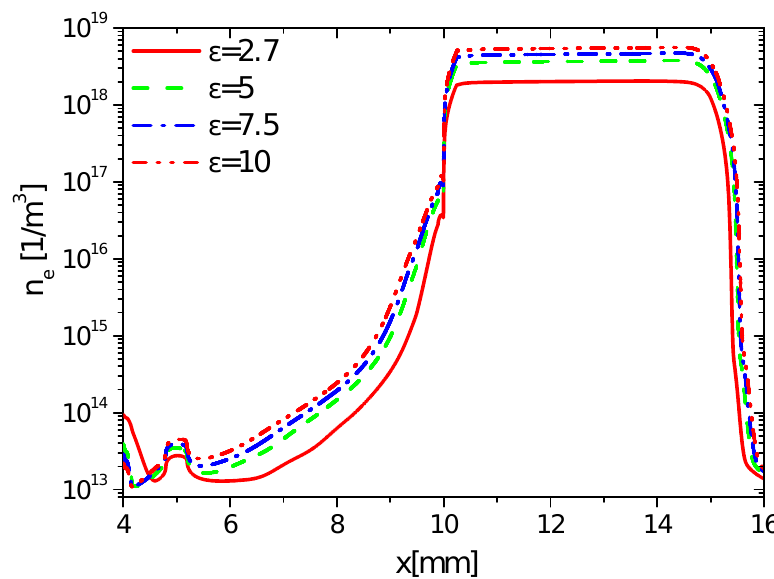
Figure 12. Effect of ε on the distributions of n e at 35 ns in the fall phase.